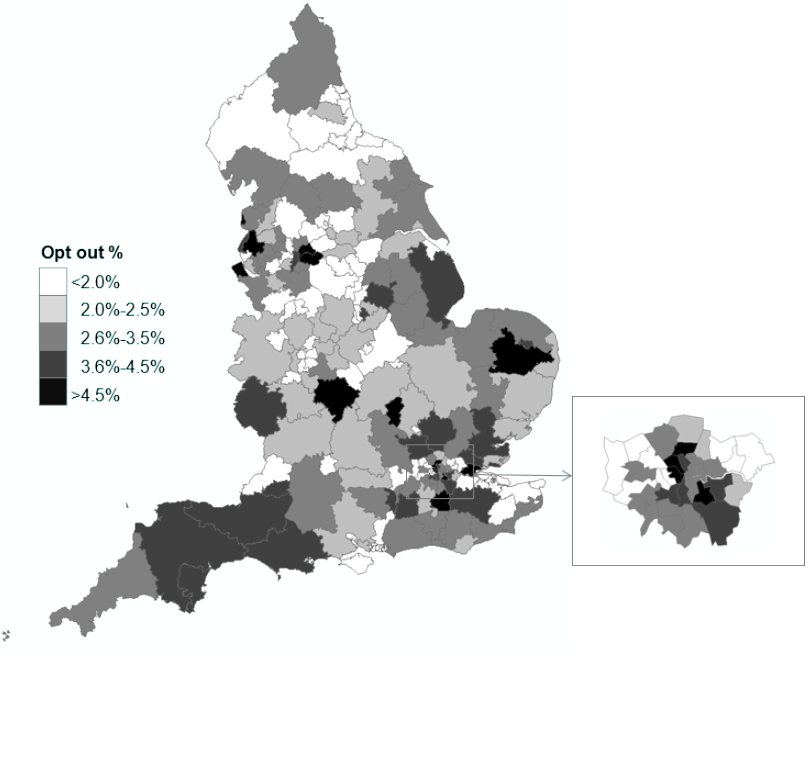
Figure 1: Rates of patients opting out, by CCG: England (with inlay map of London CCGs), as at December 2018. Data from NHS Digital [21]